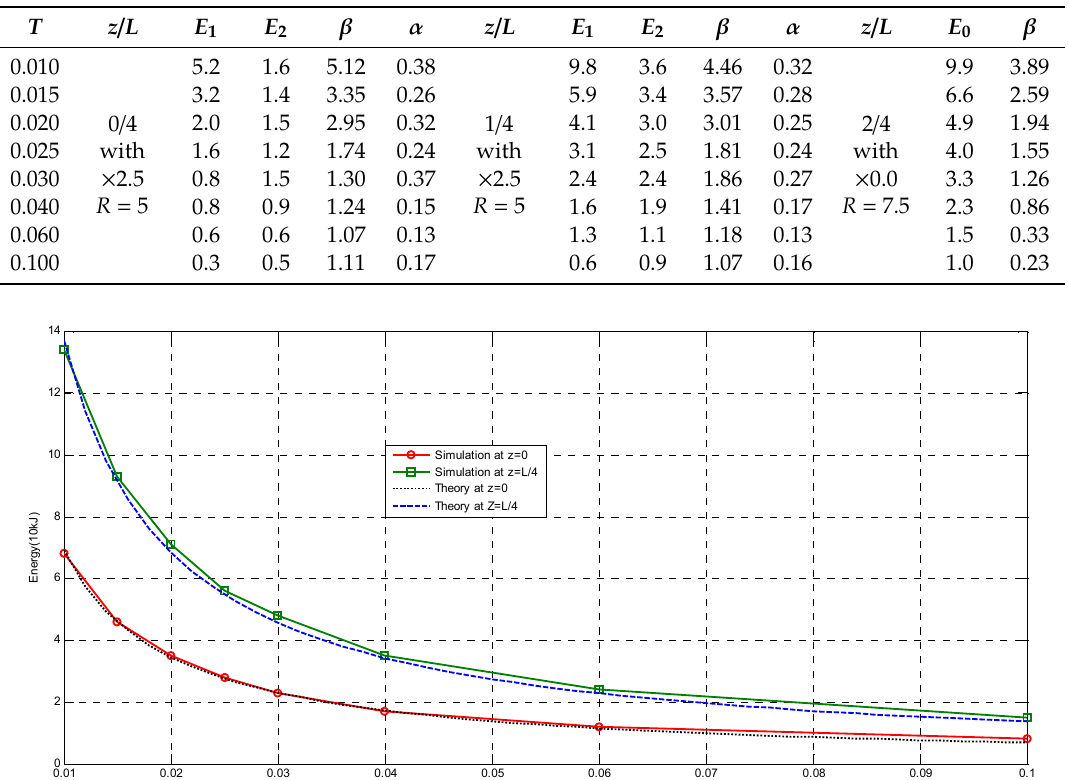
β at different T /m.